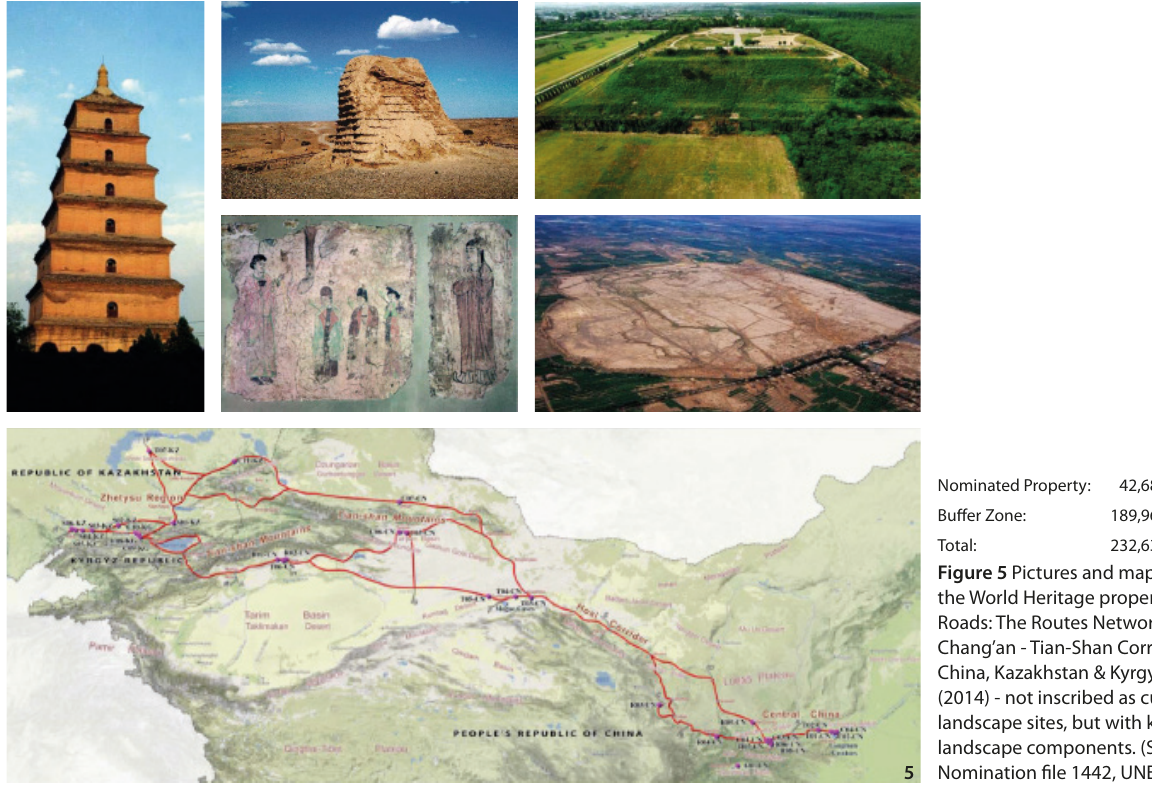
Figure 5 Pictures and map of the World Heritage property ‘Silk Roads: The Routes Network of Chang’an - Tian-Shan Corridor, China, Kazakhstan & Kyrgyzstan’ (2014) - not inscribed as